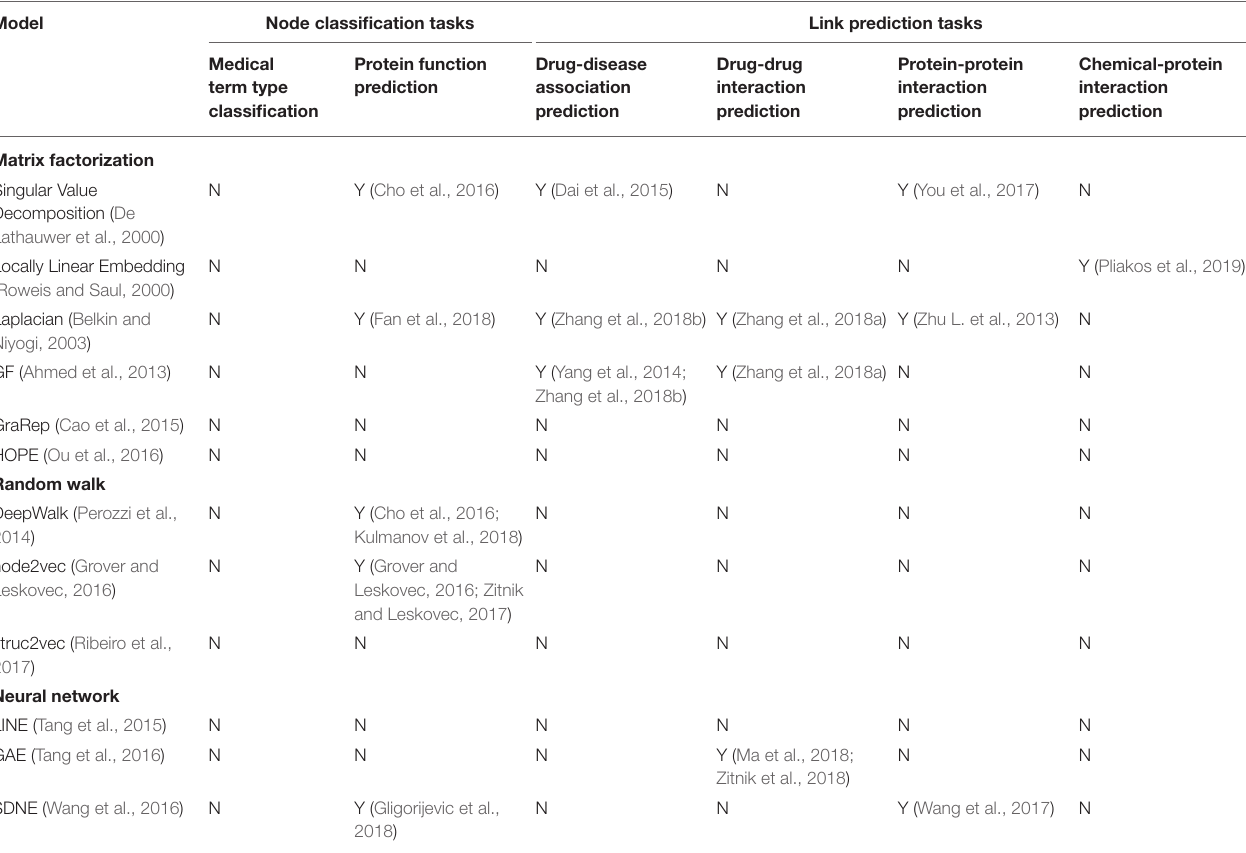
TABLE 1 | A summary of 12 representative graph methods and existing work using them for a biomedical graph